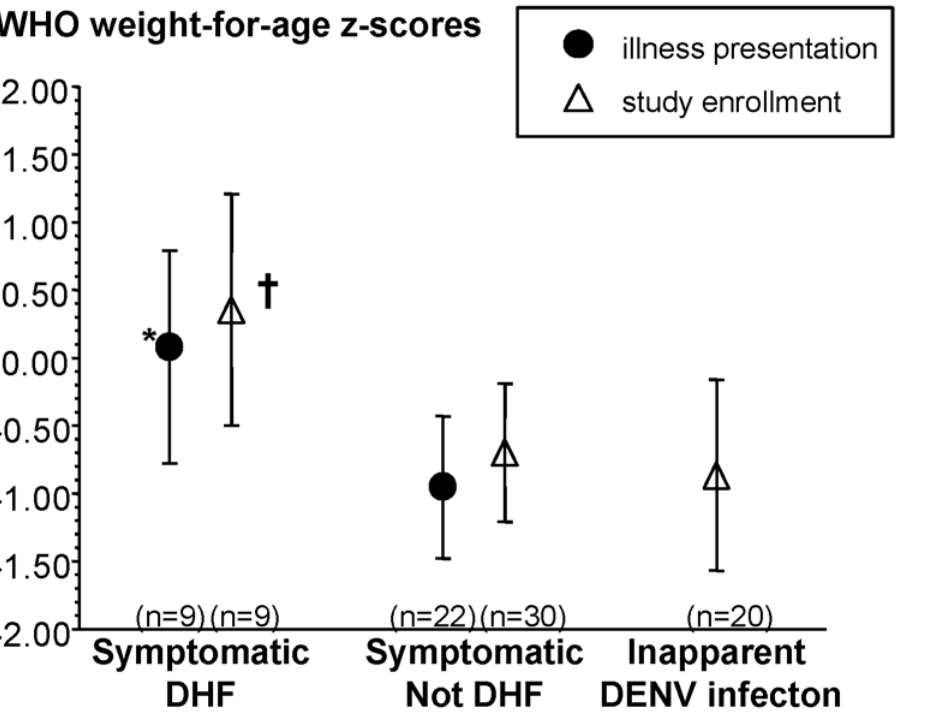
Figure 3. World Health Organization (WHO) weight-for-age z-scores at study enrollment and acute illness in infants with primary DENV infections. Closed circles, weight-for-age z-scores at illness presentation; open triangles, weight-for-age z-scores at study enrollment. Values are presented as the mean with 95% CIs. *, p =0.04, weight-for-age z-scores at presentation in DHF infants versus symptomatic dengue, not DHF, infants. { , p =0.03, weight-for-age z-scores at study enrollment in DHF infants versus symptomatic and inapparent dengue, not DHF,